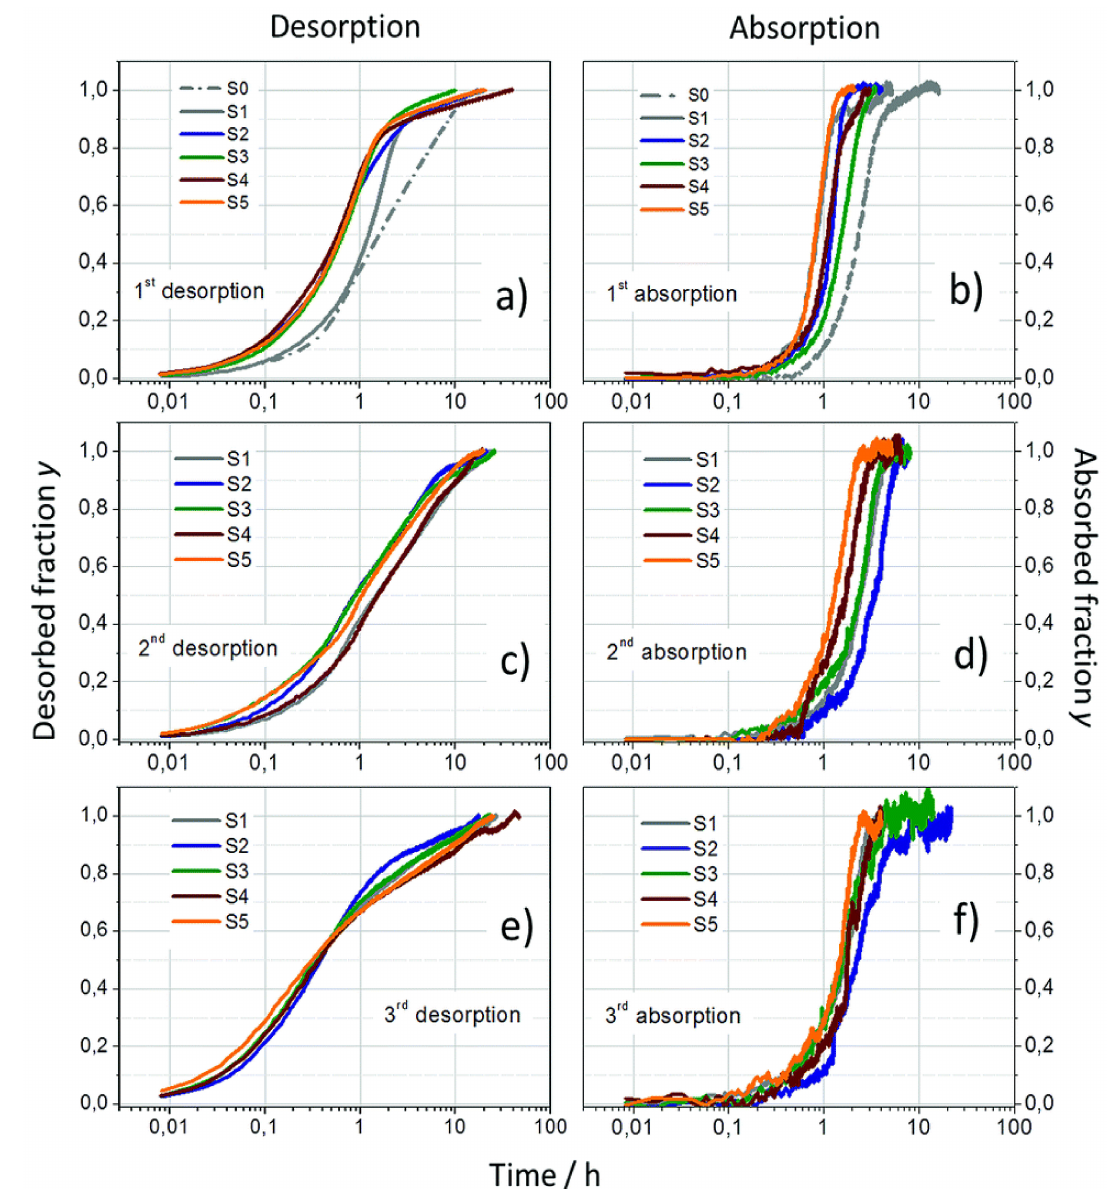
Figure 4. Isothermal desorption kinetics ( a , c , e ) and absorption kinetics ( b , d , f ) of different sam- ple S0–S5 during 3 cycles. γ -Mg(BH 4 ) 2 as received (S0), γ -Mg(BH 4 ) 2 ball-milled (S1), and γ -Mg(BH 4 ) 2 + 2 mol% X (X = CoF 3 (S2), Co 2 B (S3), CoCl 2 (S4), Co 3 O 4 (S5))